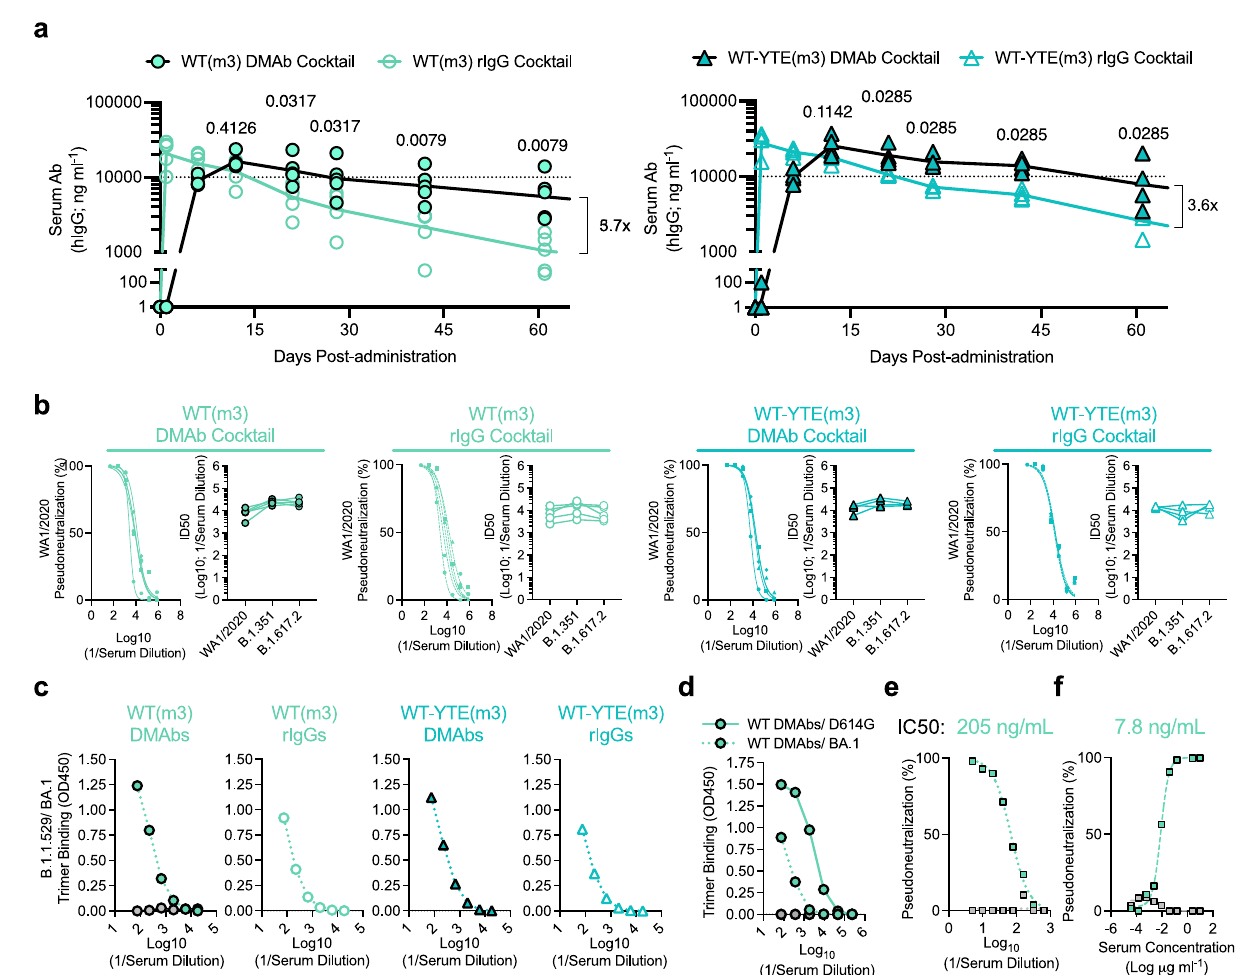
Fig. 5 | In vivo delivery and half-life engineering (YTE) contribute to improved durabilityoffunctionalDMAbscomparedtobioprocessedrIgGinhFcRnmice. 6 – 8-week-oldfemalehFcRnmice( n =4(WT)or5(WT-YTE)independentbiological replicates) were administered plasmids encoding the indicated DMAb cocktails (100 µ g/animal) or rIgG cocktails (100 µ g protein/animal; IP). a Individual serum levels (and group GM±GSD) of the indicated DMAbs or rIgG mAbs are shown ( n =12). Group titers at each time point were compared using a two-tailed Mann – Whitney U test. P values indicated. Fold (x) difference in average titers between the indicated groups at D60 post-administration is depicted. b Neutralizing activity of all individual hFcRn serum samples ( n =4 – 5/group) against wildtype (USA-WA1/2020) or B.1.351 and B.1.617.2 variant pseudoviruses; neutralization curves against WA1 − 2020 (best- fi t lines and individual data points